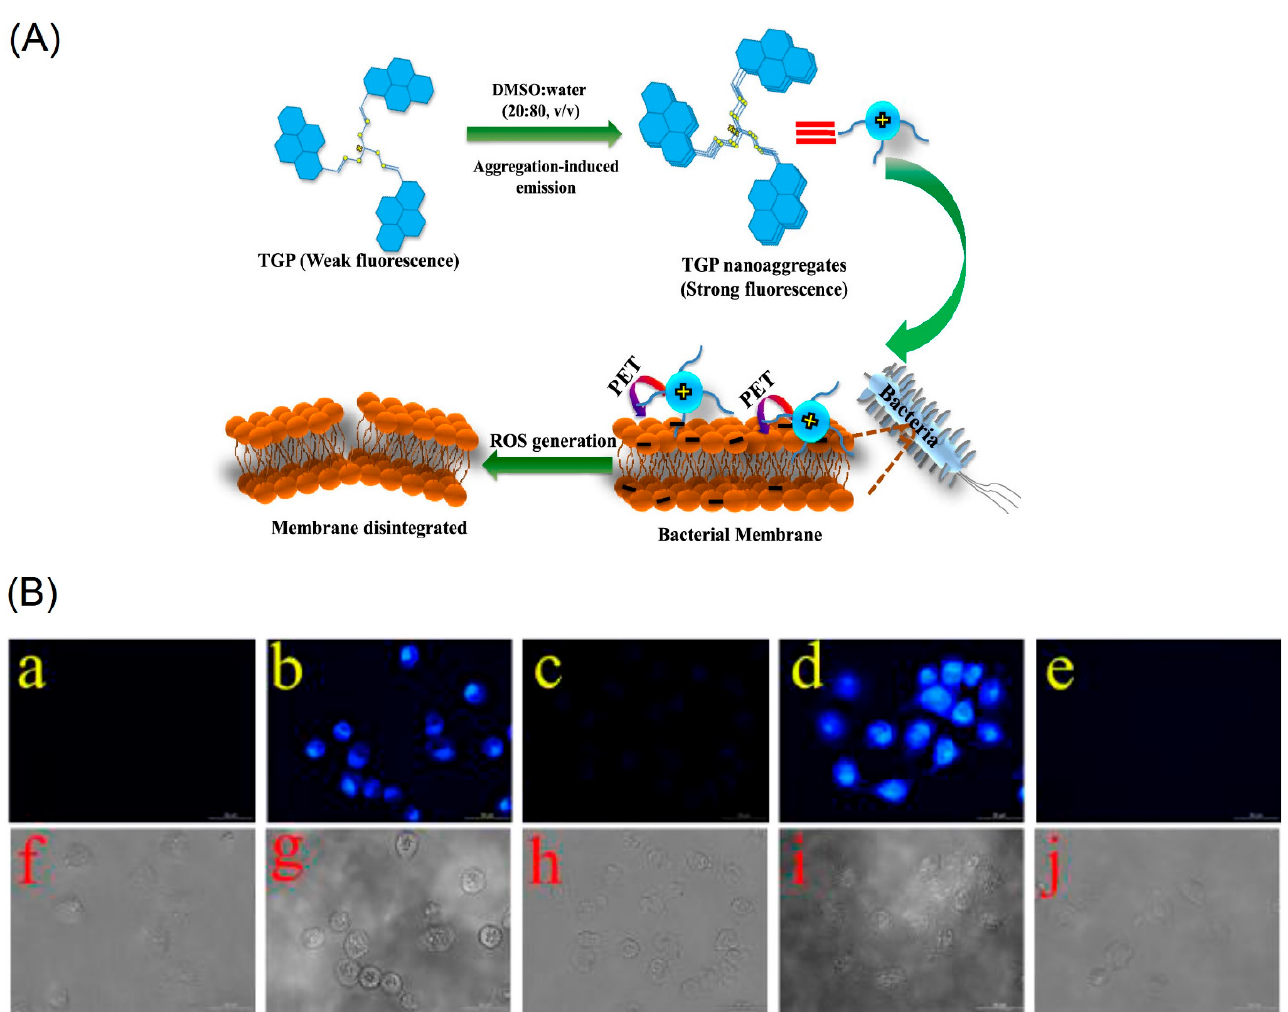
Figure 12. ( A ) Schematic representation of C16 (noted as “ TGP ” in the original report) in the molecular state, their self-assemblies in the aggregated state and proposed interactions with bacterial membrane exhibiting broad-spectrum antimicrobial activity (Reproduced with the permission from Ref. [84]). ( B ) Fluorescence images of H1299 cells. ( a ) Fluorescence images of cell. ( b ) Fluorescence images of cells incubated with probe 1 (10 µM) for 20 min at 37 °C. ( c ) Fluorescence images of cells pretreated with N-methylmaleimide (100 µM) for 1 h at 37 °C and then incubated with C17 (5 µM; noted as “ Probe 1 ” in the original report) for 20 min at 37 °C. ( d ) Fluorescence images of cells incubated with probe 2 (5 µM) for 20 min at 37 °C. ( e ) Fluorescence images of cells pretreated with N-methylmaleimide (100 µM) for 1 h at 37 °C and then incubated with C18 (1 µM; noted as “ Probe 2 ” in the original report) for 20 min at 37 °C. ( f – j ) are the corresponding bright field images of ( a – e ) (Reproduced with the permission from Ref. [85]).